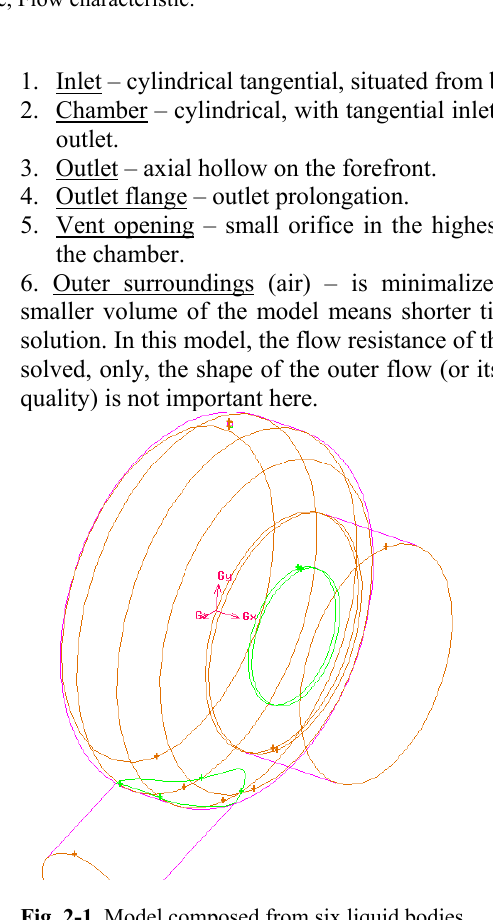
Fig. 2-1. Model composed from six liquid bodies